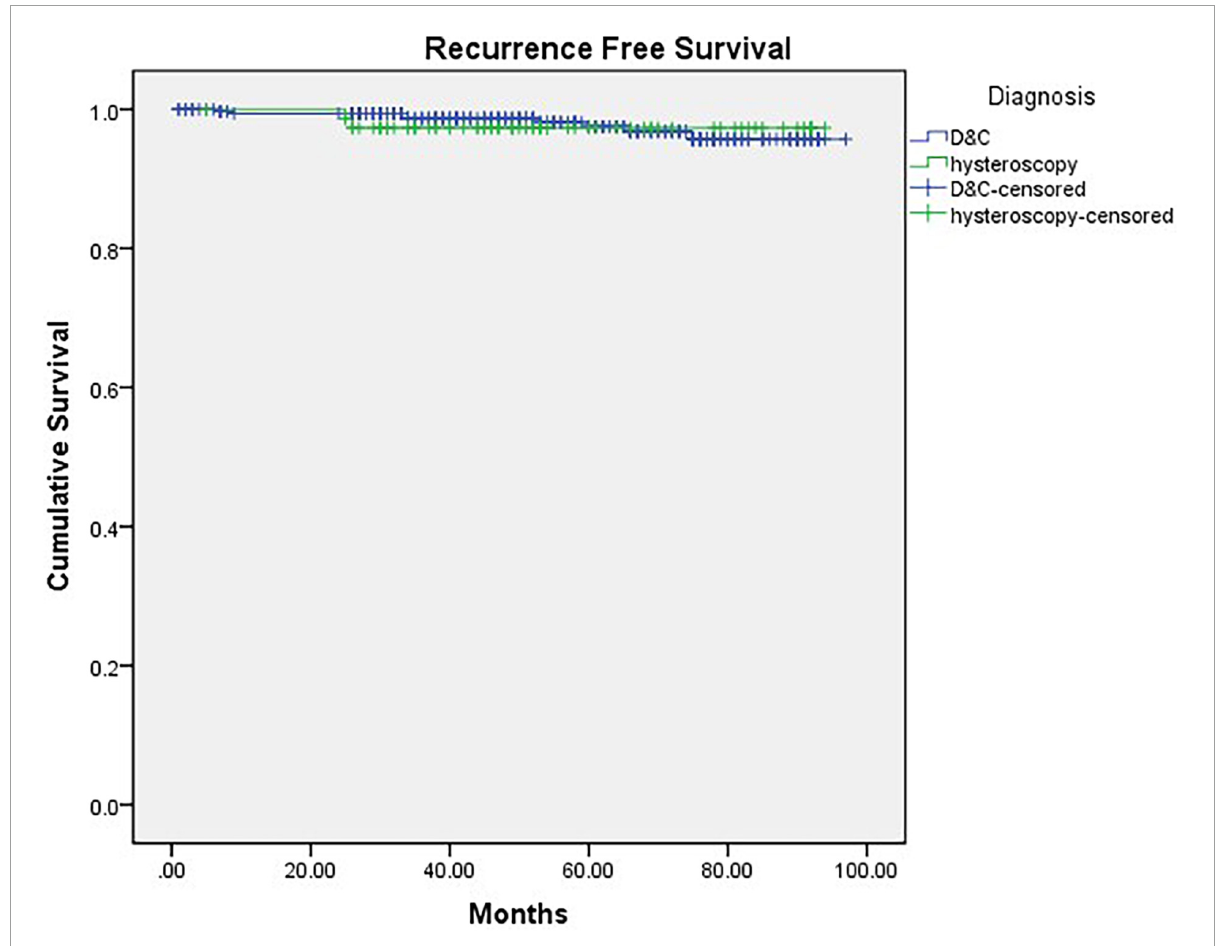
FIGURE2 Kaplan-Meier curve of recurrence-free survival grouped by diagnostic procedure ( p =